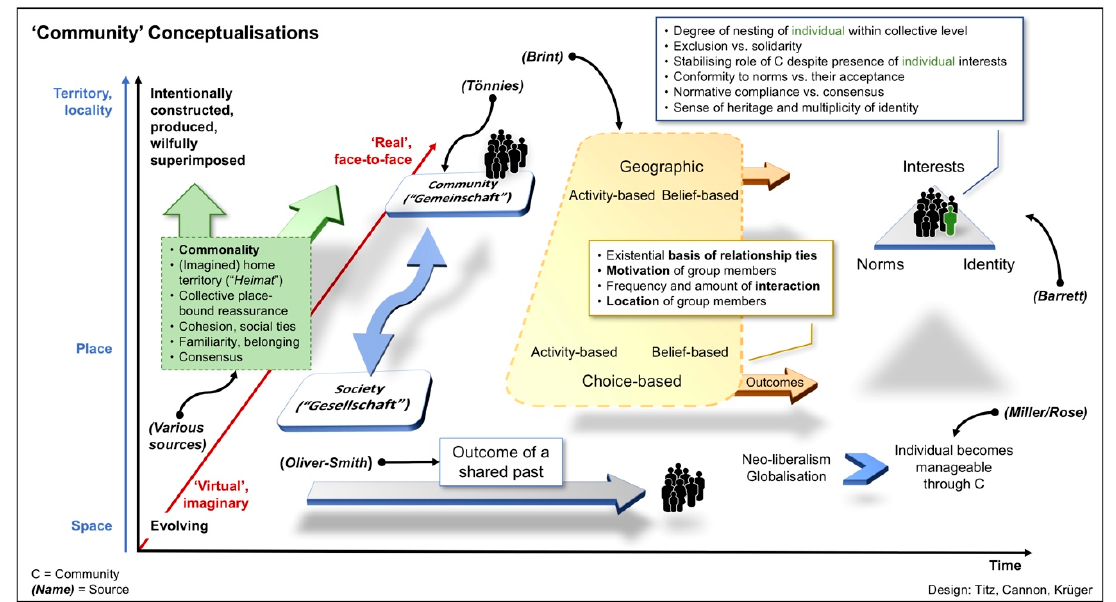
Figure 1. ‘Community’ Conceptualisations.